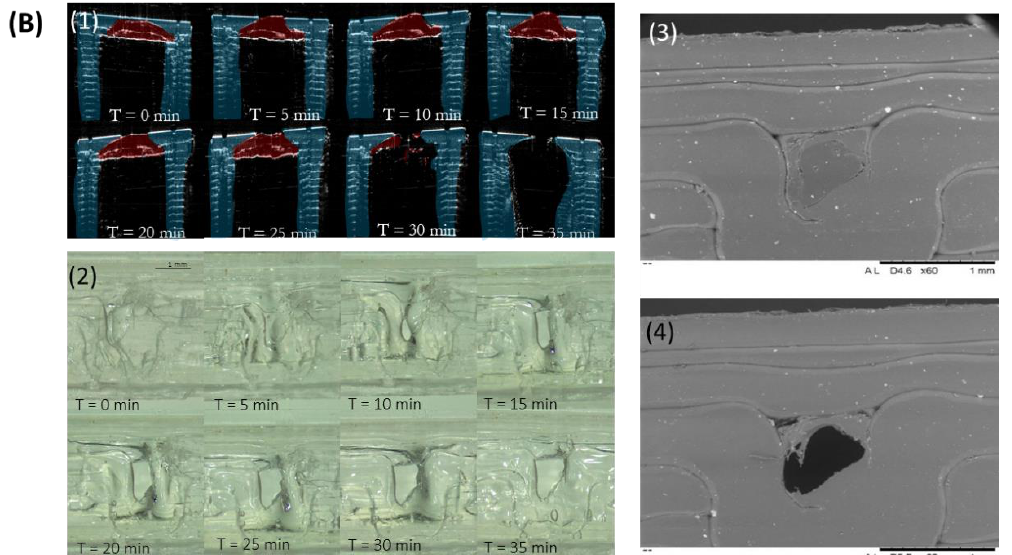
Figure 5. Force required to break each of the implant designs ( n = 5, means + SD).